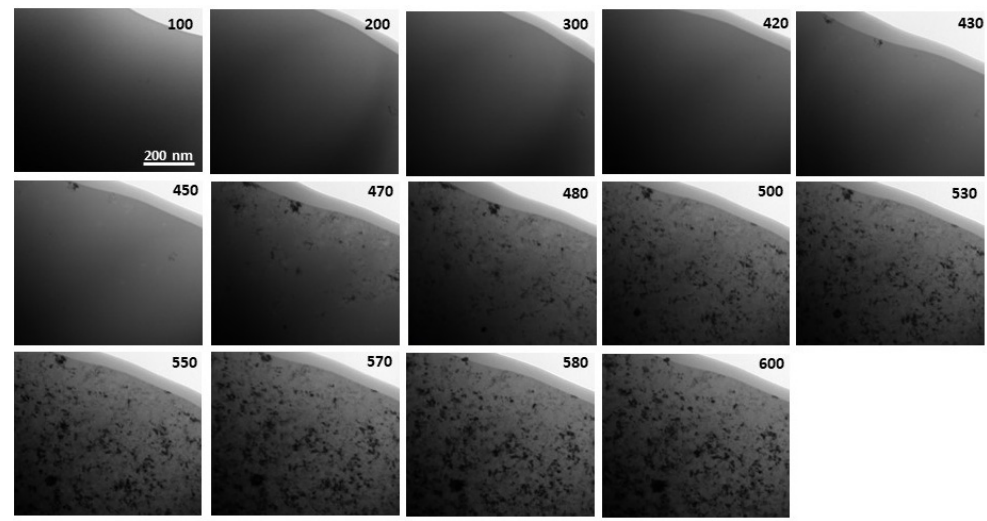
Figure 6. A set of BF images recorded for the Fe 64.5 Co 20 Nb 5 B 8.5 P 2 ribbon during in situ heat treatment up to 600 °C.